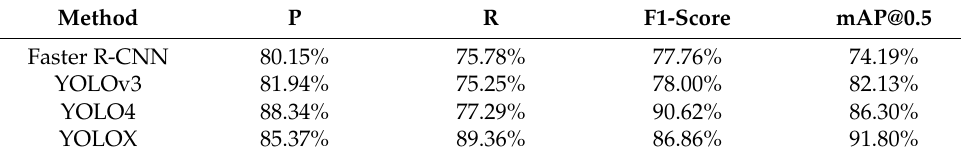
Table 4. Comparison of test results of different models under the test dataset HPD.